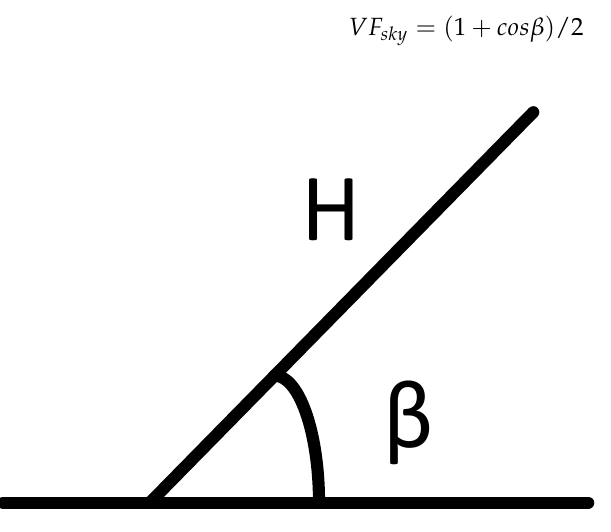
Figure 2. Single collector. A single inclined collector, β , of width, H , deployed on a slopped plane, ε , is shown in Figure 3.